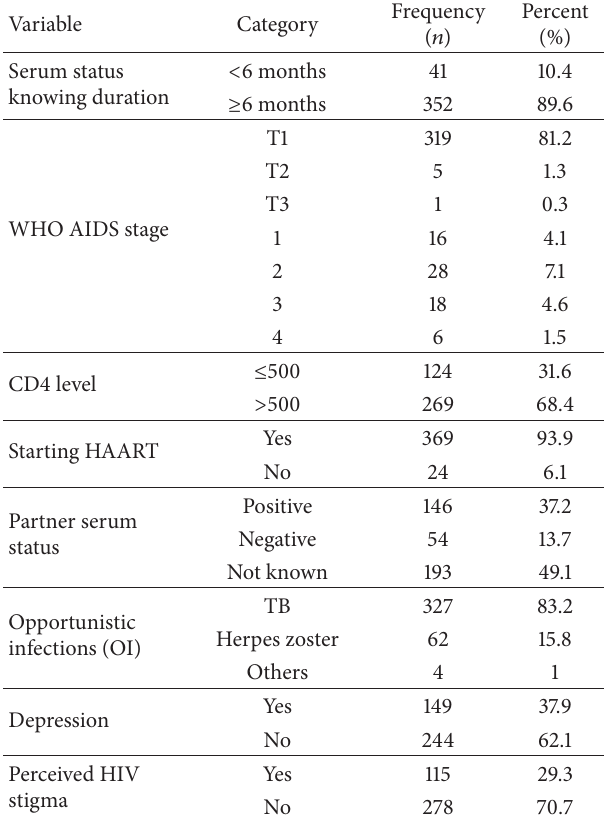
Table 2: Clinical characteristics of HIV positive patients at Debark Hospital Northwest, Ethiopia, 2015 ( 𝑛 = 393 ).